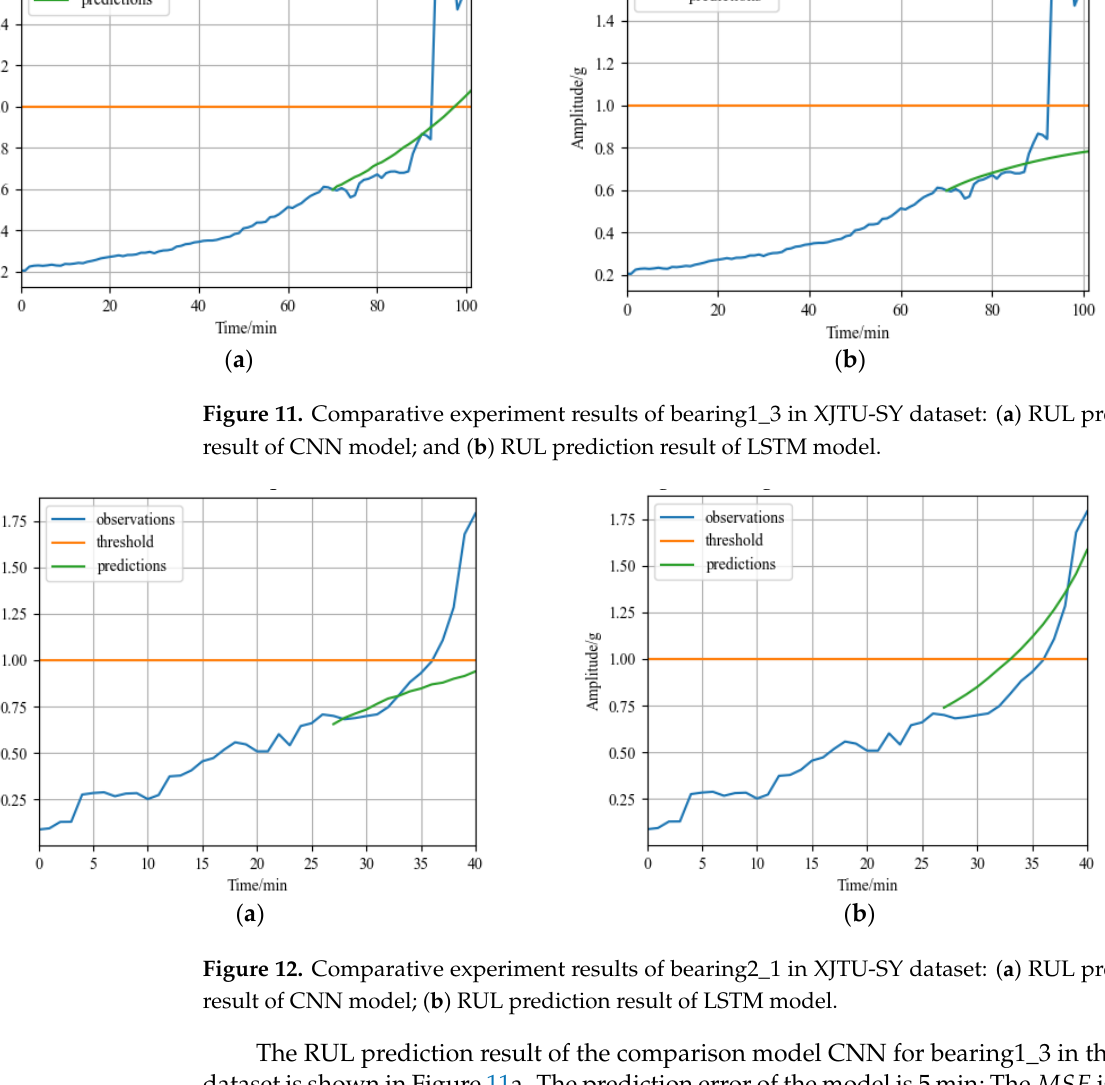
Figure 11. Comparative experiment results of bearing1_3 in XJTU-SY dataset: ( a ) RUL prediction result of CNN model; and ( b ) RUL prediction result of LSTM model.